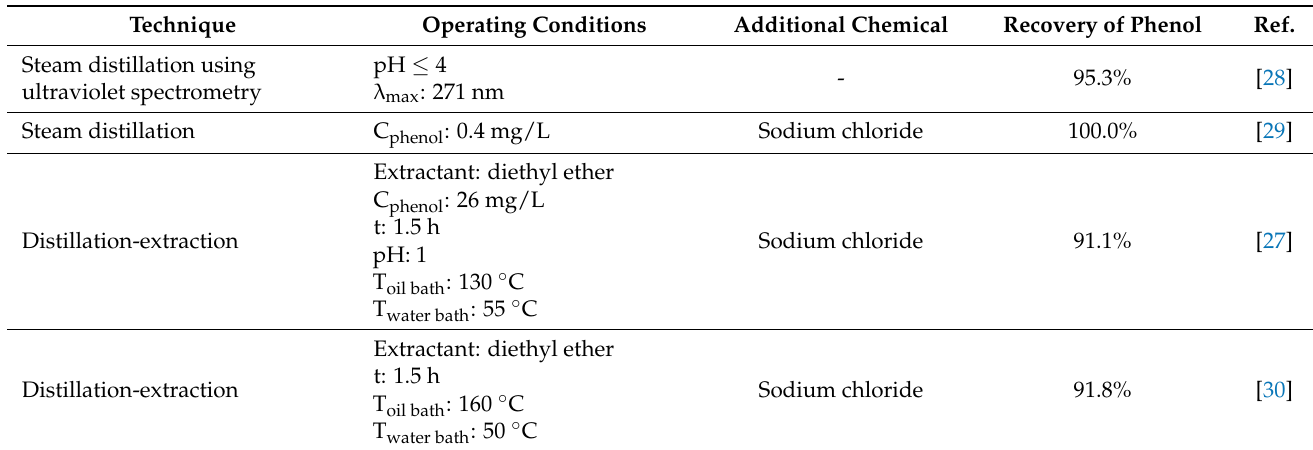
Table 3. Comparison of phenol recovery using distillation-based